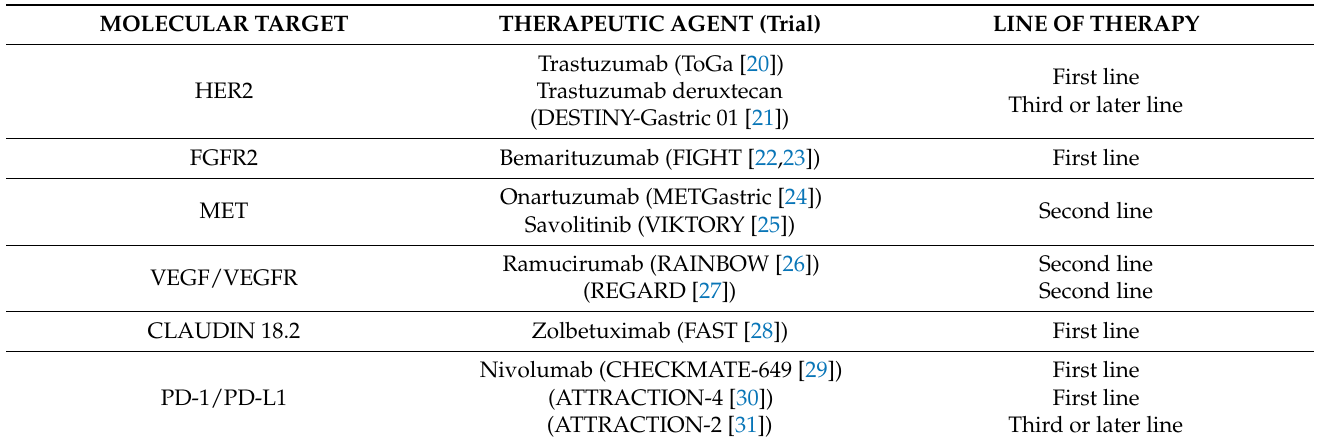
Table 3. Principal and promising targeted and immunotherapies in advanced gastric